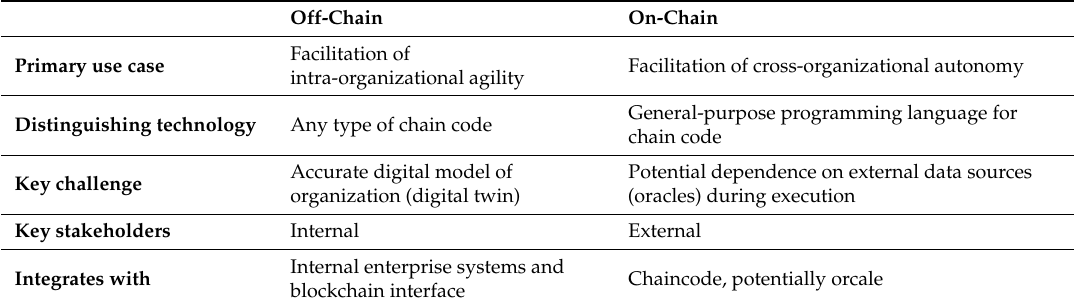
Table 2. Overview: Key difference between off-chain and on-chain simulation scenario